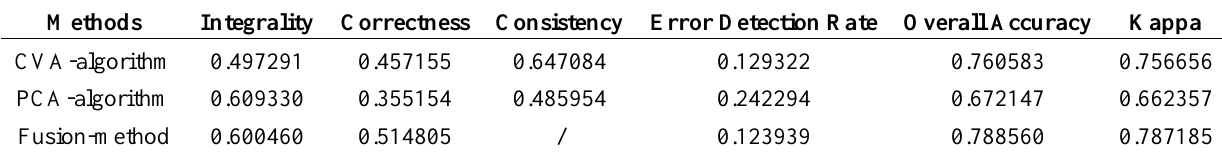
Table 1. Comparison of reliability and accuracy.